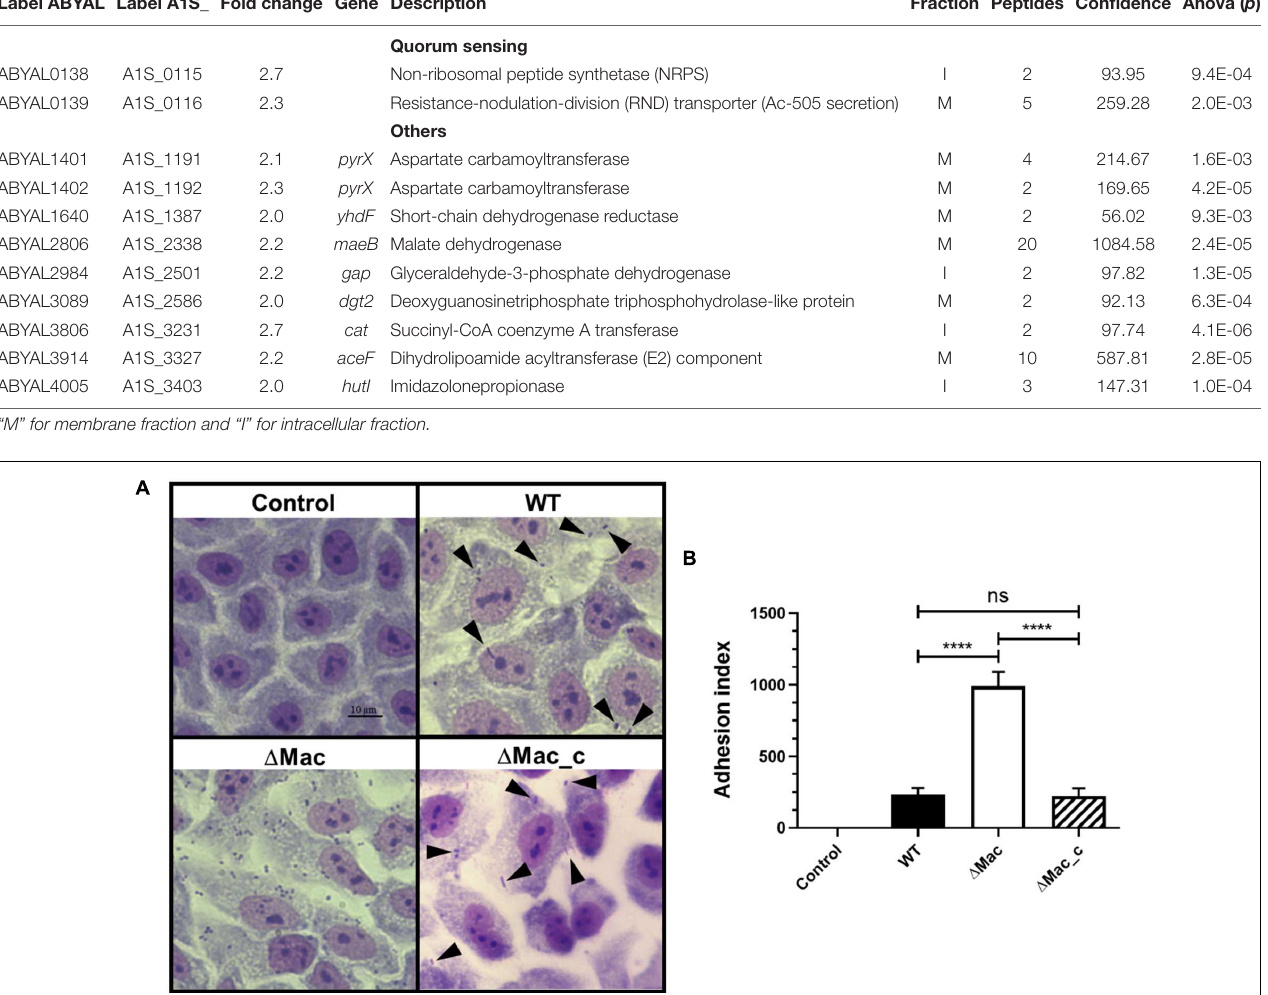
TABLE 2 | Over-represented proteins in solid–liquid biofilm of (cid:49) Mac. Label ABYAL Label A1S_ Fold change Gene Description Fraction Peptides Confidence Anova ( p )